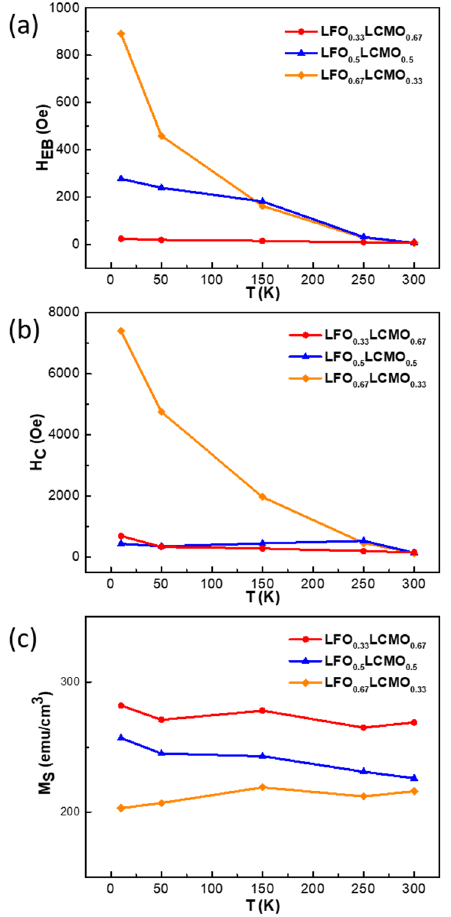
Figure 4. Magnetic properties comparison of the composite thin films with different compositions, which are ( a ) H EB value, ( b ) H C value and ( c ) M s value, ( b ) H value and ( c ) M value. C s